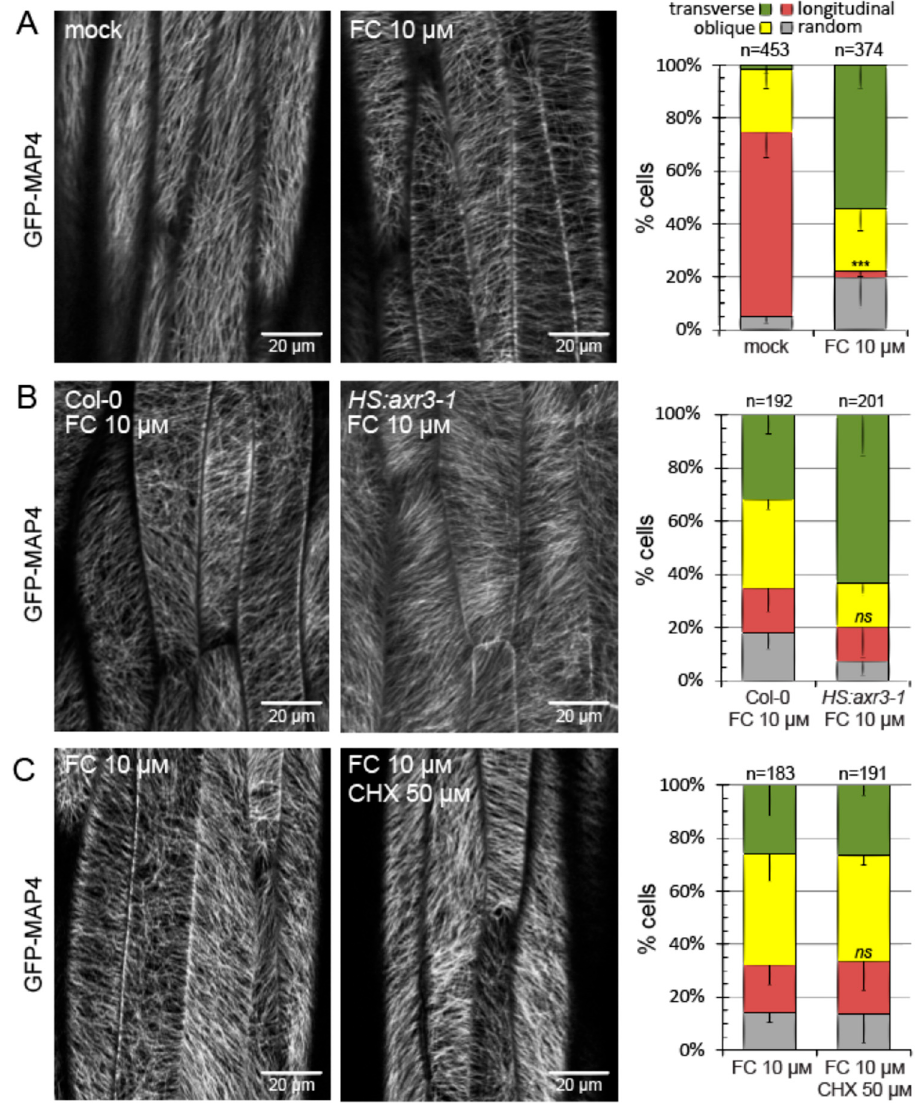
Figure 6. Fusicoccin-induced growth causes microtubule array reorientation in the absence of auxin signaling. ( A ) Auxin depleted hypocotyl segments induced to grow with fusicoccin (FC, 10 µ M) for one hour exhibit transversely oriented microtubule arrays. ( B , C ) Additional controls ascertaining auxin-independence of the effect. Fusicoccin can induce transverse microtubule array reorientation in the growing hypocotyls of the auxin signaling mutant HS:axr3-1 and following the inhibition of protein translation by cycloheximide (CHX, 50 µ M). The GFP fluorescence is depicted in grayscale. The graph shows average percentage of cells in each category from three experiments. Error bars indicate standard deviation (only the lower bar is shown for clarity). Total cell numbers are given above each graph. The frequencies of cells with longitudinal arrays were compared using t tests, p = 0.0003 (***) in A , p = 0.6569 in B and p = 0.813 in C . ns—not significant.